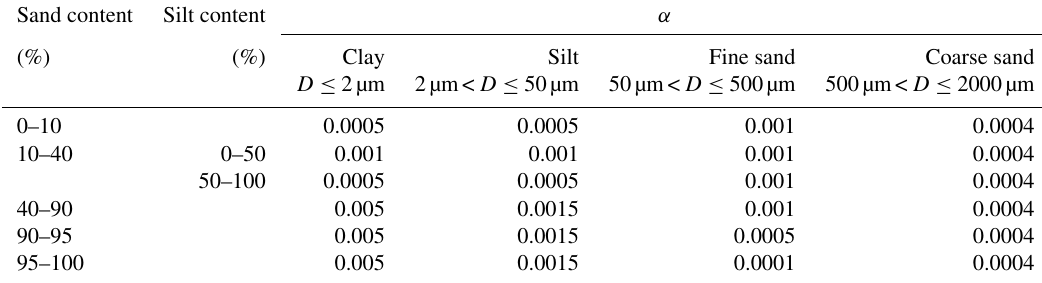
Table 3. The estimated values of α for various soil textures.